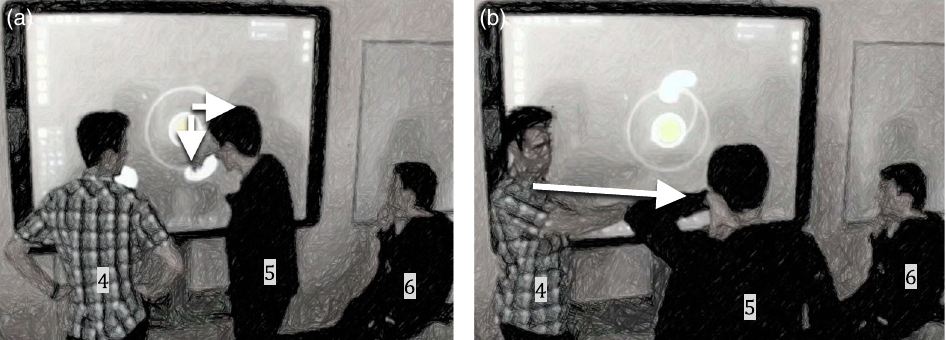
FIG. 10. Student 5 proposes an explanation for how the planet starts orbiting around the Sun (the planet moves forward faster than it moves towards the Sun). To that, student 4 replies that the planet also should not move too fast, otherwise it will fly away and not return. The students do not agree on whether there is such an escape velocity. Student 5 claims that the planets will always return, but their orbits do not necessarily have a perfect circular shape.